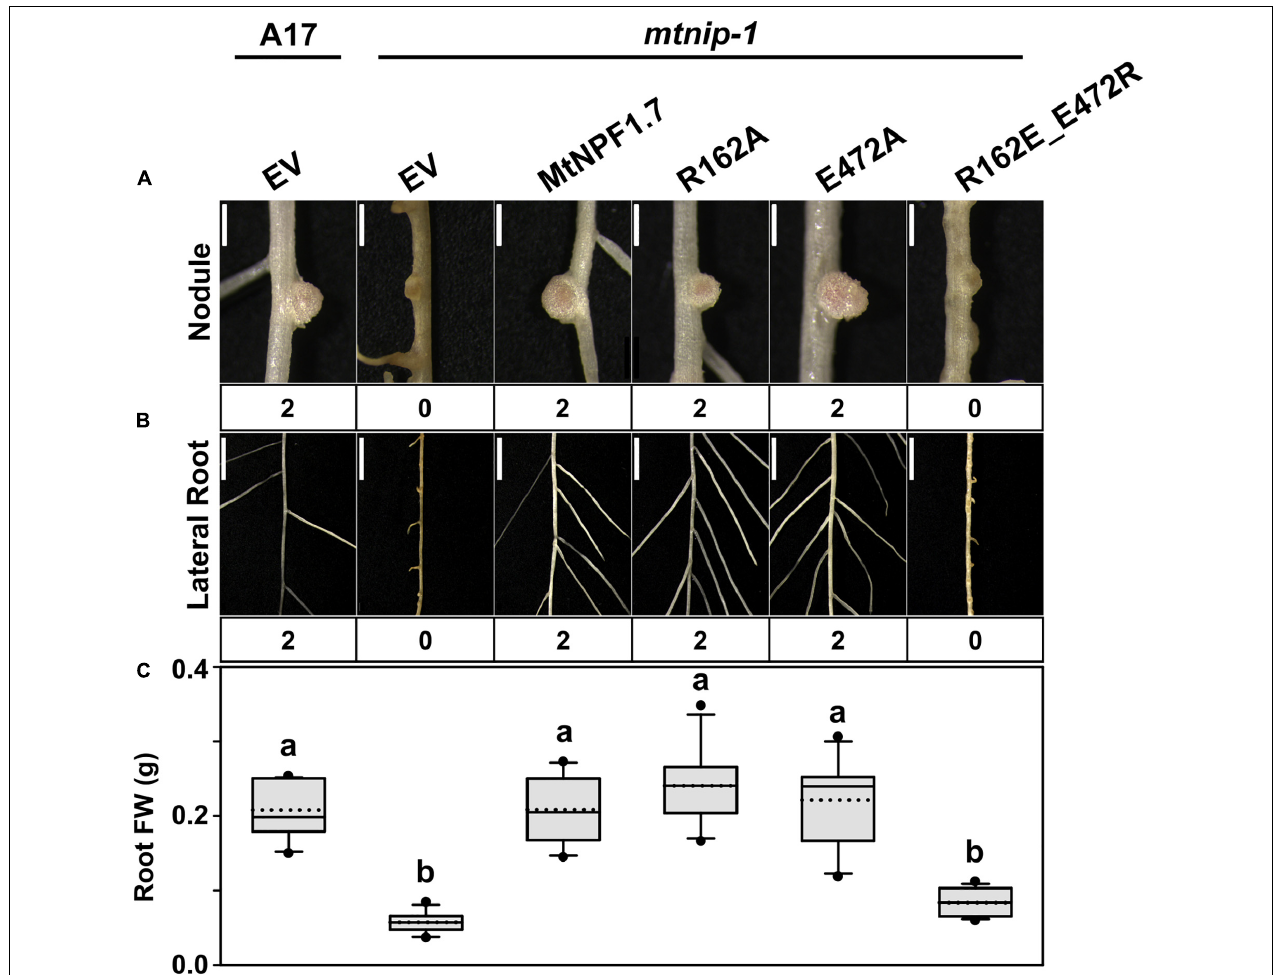
FIGURE 3 | Results of in planta complementation with the TMH4-10 salt bridge mutants. Images showing (A) the nodules and (B) the lateral roots of (from left to right) A17 plant roots transformed with the pMU06 empty vector (EV) and mtnip-1 plant roots transformed with EV, MtNPF1.7_wt (pYCY400), _R162A (pYCY407), _E472A (pYCY408), and _R162E-E472R (pYCY411). Nodules and lateral roots were evaluated by complementation levels shown below each image as described in Figure 2 . (A) Bars = 1 mm. (B) Bars = 5mm. (C) Plot of root fresh weight from ten independent transgenic plants. See Figure 2D for statistical details. Plants transformed with the MtNPF1.7_R162A and _E472A mutants have a restored phenotype. The double mutant, MtNPF1.7_R162E-E472R, designed to swap the charges of the putative TMH4-TMH10 salt bridge does not rescue the mutated